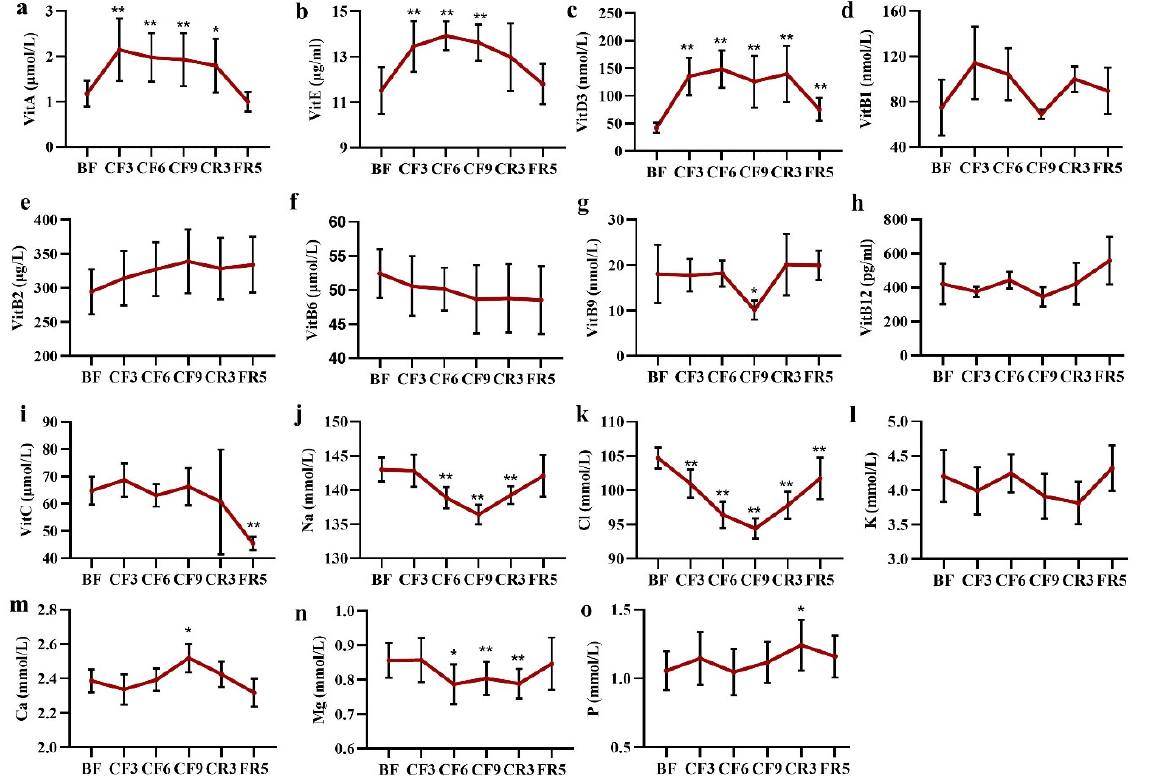
Figure 8. The alteration of main vitamin ( a – i ) and electrolyte ions ( j – o ) during 10-day CF and refeeding period. * p < 0.05, ** p < 0.01 vs. BF; n = 13. BF: before fasting, CF: complete fasting, CR: calorie restriction, FR: ful recovery; the number depicts days. Vit: vitamin.